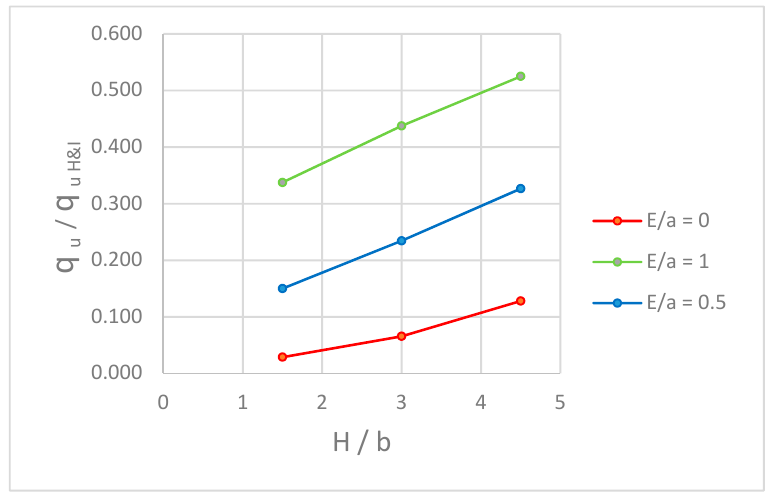
Figure 9. The relative ultimate bearing capacity with the cover H/b for E/a < 2.